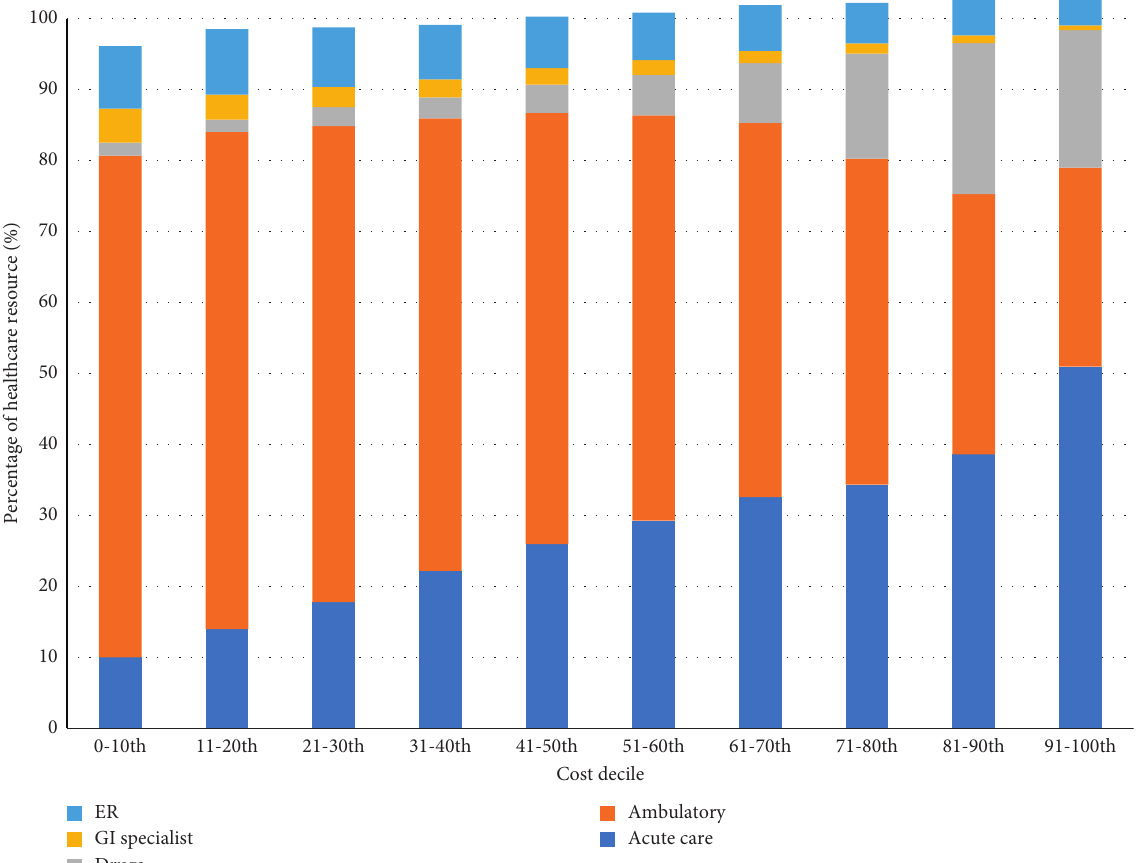
Figure 5: Healthcare resource utilization in young adults with cirrhosis by cost decile in 2016. ER: emergency room; GI: gastroenterology.